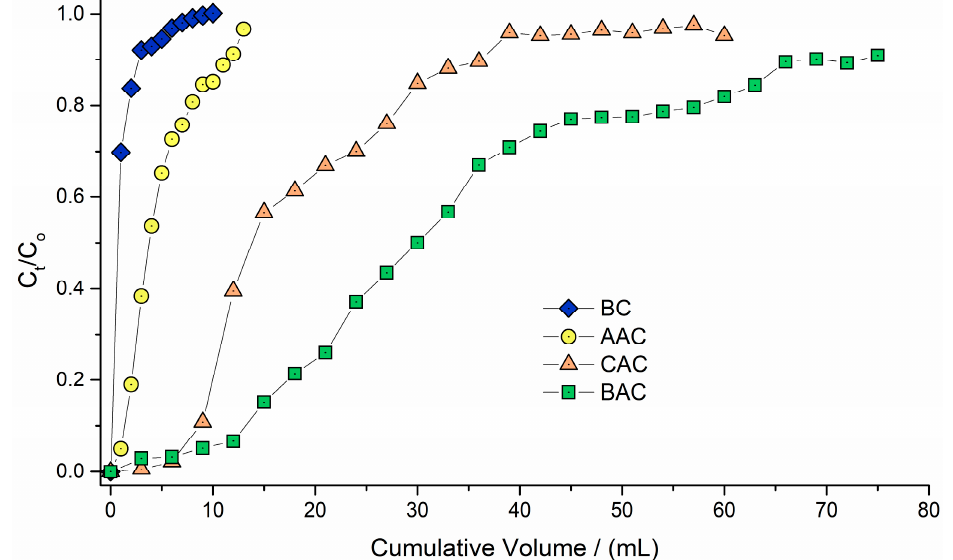
Figure 6. Fixed bed adsorption results for the four adsorbents. Conditions: 60 mg·L − 1 of isoniazid concentration at pH 6.8; 15 mg of adsorbent in a reactor diameter 5.31 mm; reactor volume of 1.3 cm 3 and 6.11 mm of biochar column height, flow rate of 3 mL·min − 1 ; and with solution aliquots collected every 60 s for CAC and BAC and every 20 s for AAC and BC.